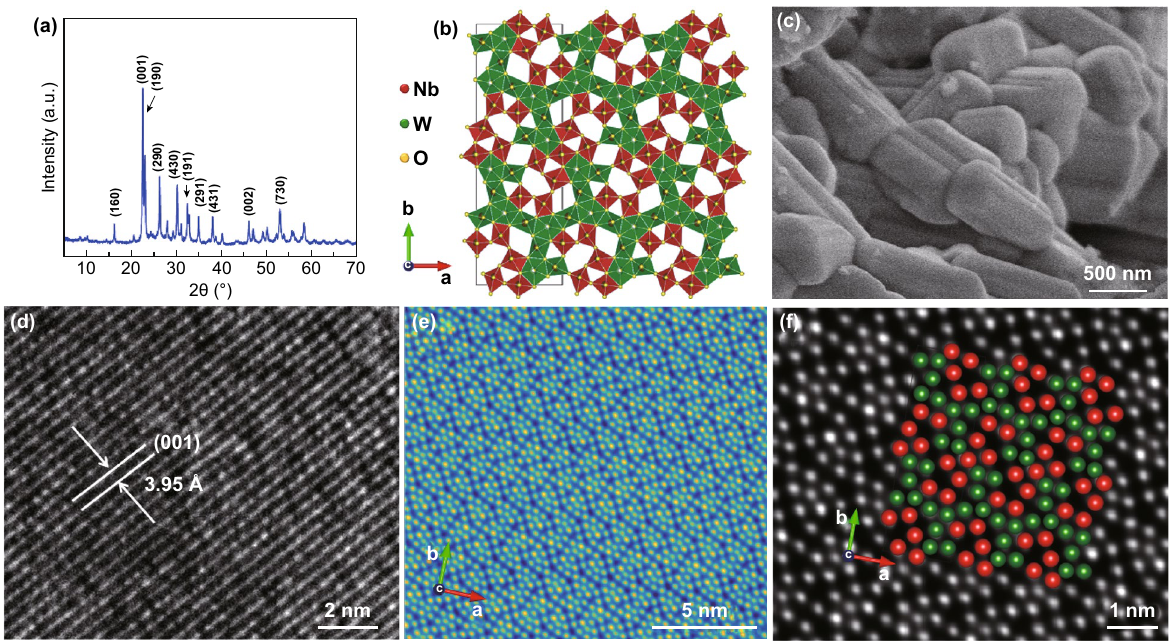
Fig. 2 Microstructural characterizations of NbWO. a XRD pattern. b Structural diagram of NbWO along the c axis. c SEM image. d HR-TEM image. e , f Aberration-corrected HAADF–STEM images of atomic arrangement which match the inset structure model viewed along the [001] crystallographic direction, W:green; Nb: red